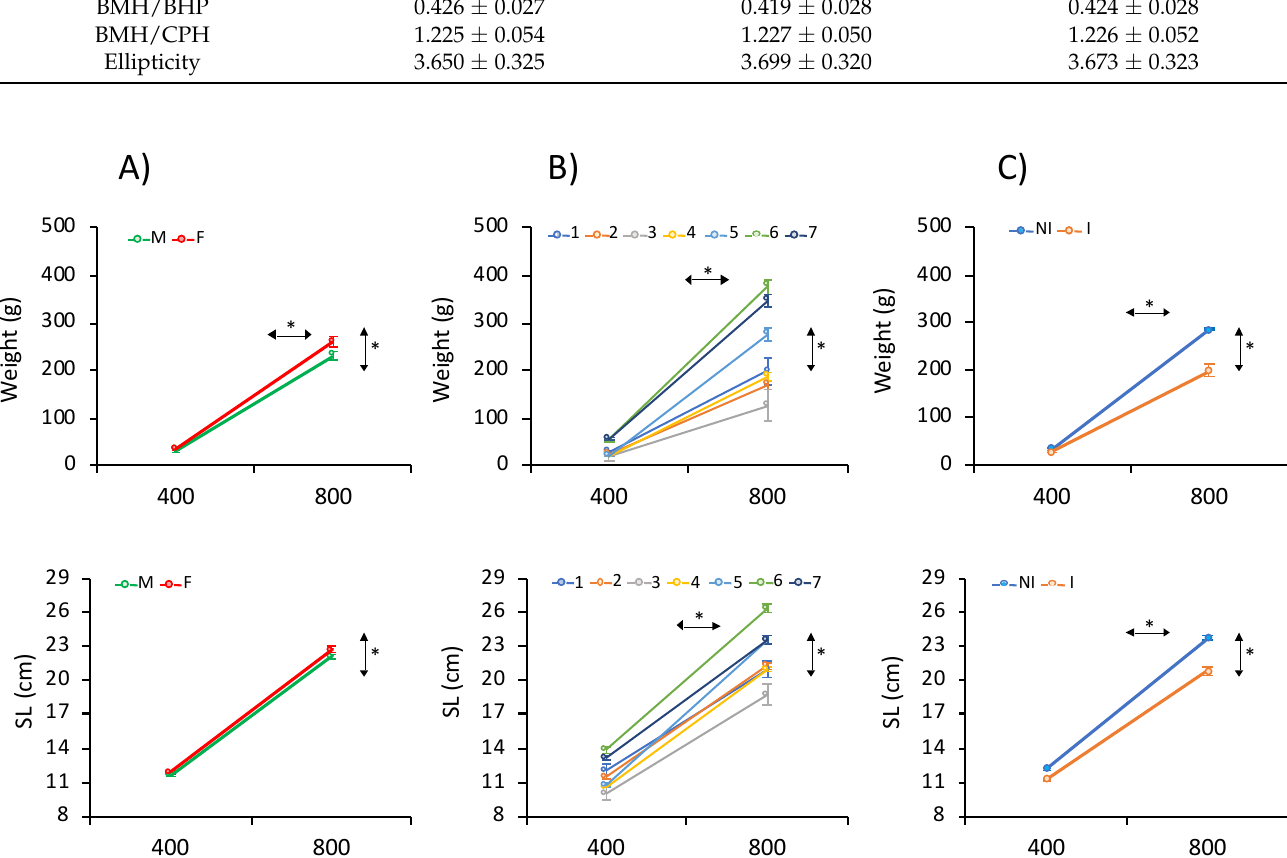
Figure 2. Estimated marginal means for weight and standard length (SL) as determined by repeated-measures ANOVA at 400 and 800 days (d) for ( A ) gender (male: M; female: F), ( B ) Evaluation Batch (EB) (1–7) and ( C ) Amoebic disease (AD) (infected: I; non-infected: NI). The asterisks (*) on the horizontal or vertical arrows denote if within- or between-subject effects were significant. Table 1. Phenotypic data for growth traits (weight and standard length (SL)), heights (body height